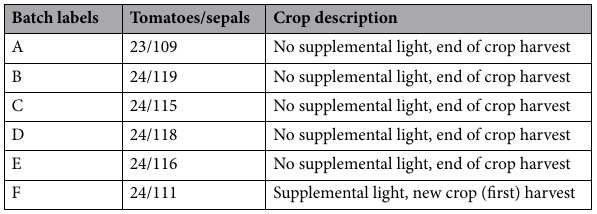
Table 1. A summary of the 6 batches of tomatoes used in the experiments.